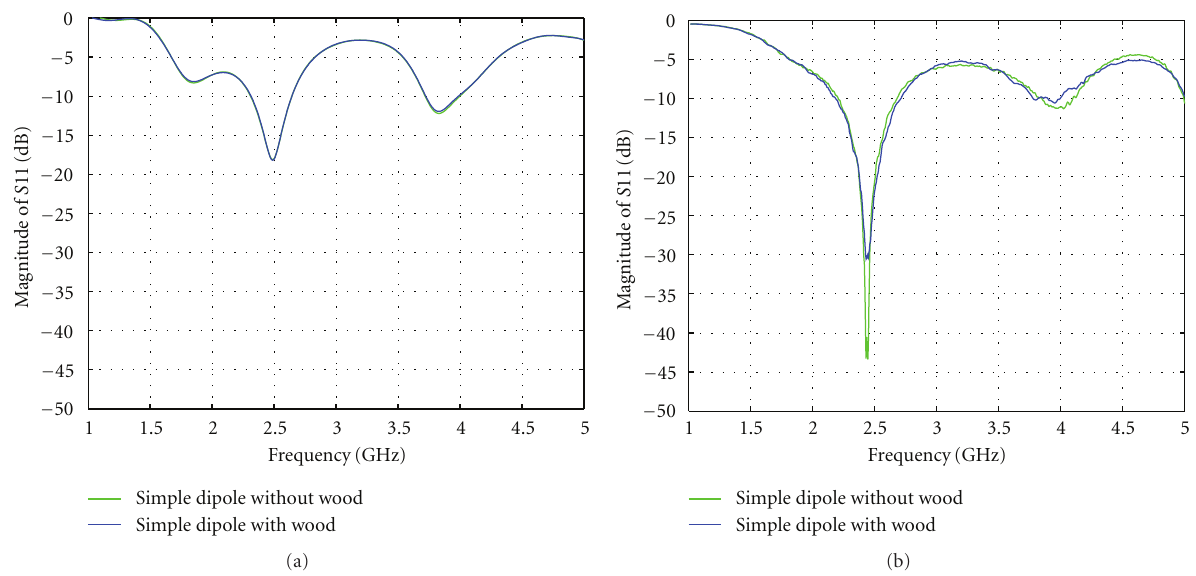
Figure 20: Magnitude of S 11 parameter of single dipole structure without wooden base and with wooden base: (a) simulated and (b) measured.